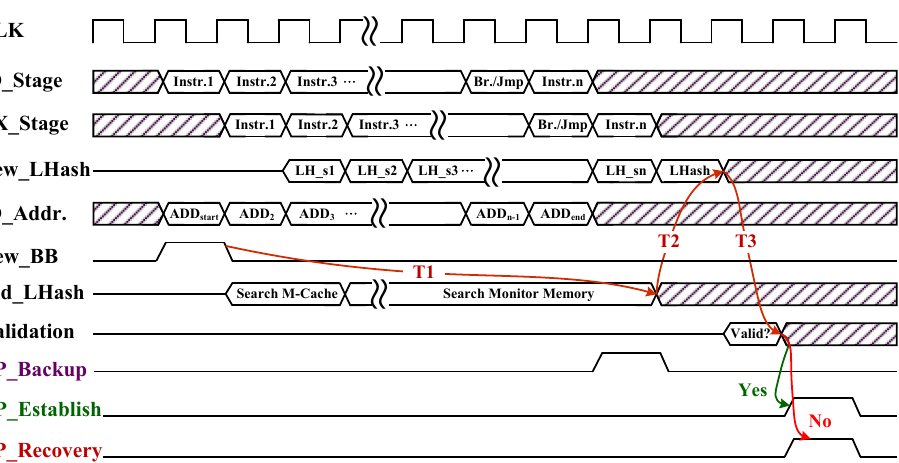
Figure 11. The timing diagram of one BB execution with integrity validation and instruction recovery in the worst